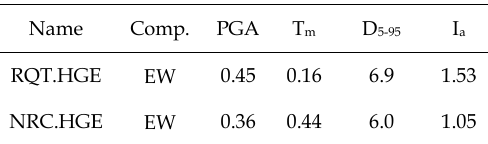
Table 2: Parameters and values adopted in the para- metric analysis.